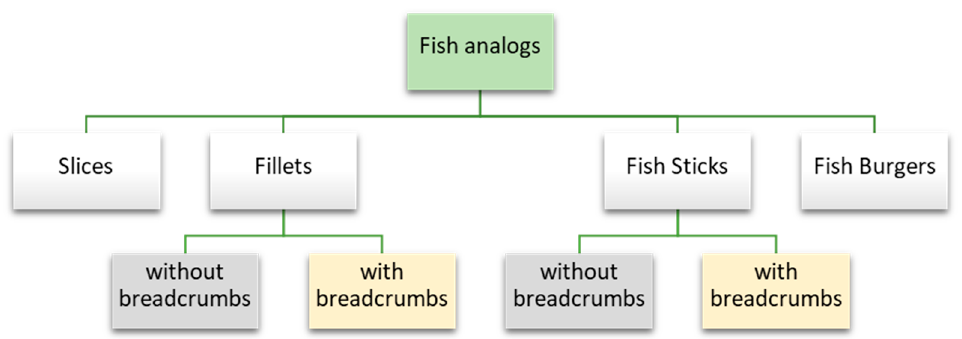
Figure 2. Types of plant-based analogs available on the market.